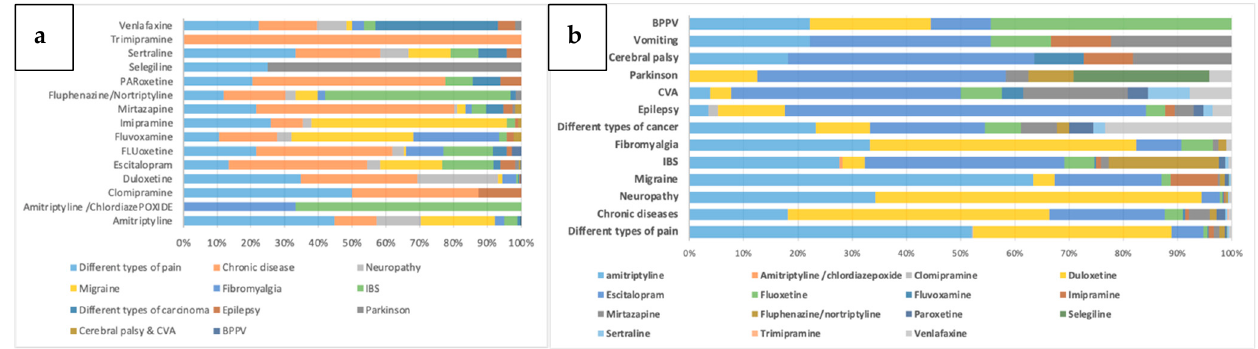
Figure 4. Non-mental health disease (non-MHD) use of antidepressants in the Qatari population, stratified into various non-MHD categories and displayed based on the ( a ) drugs, and ( b ) diagnoses. BPPV: benign paroxysmal positional vertigo, CVA: Cerebrovascular accident, IBS: Irritable bowel syndrome.